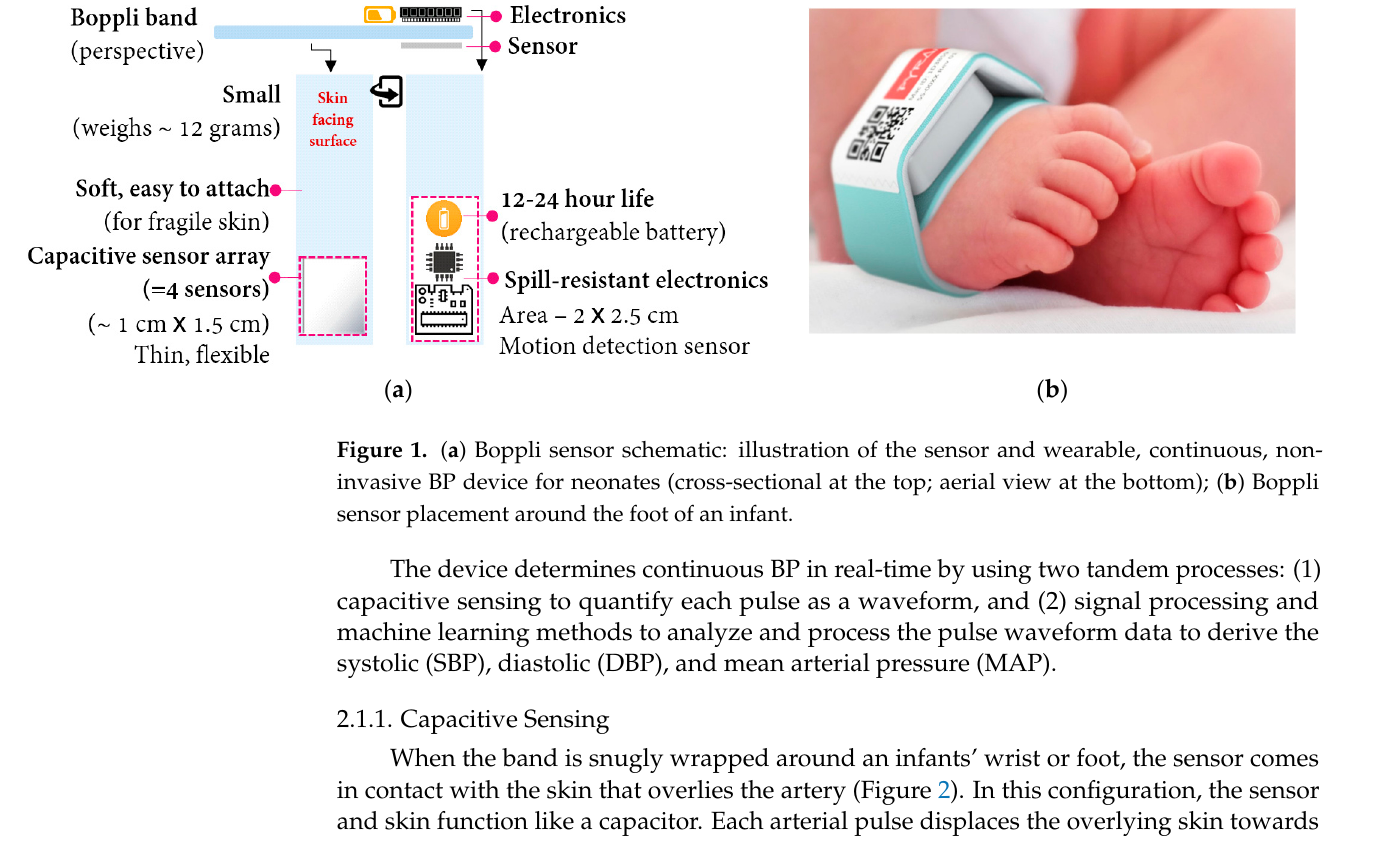
Table 2. Pipeline for real-time processing of pulse waveforms and arti fi cial neural network (ANN)